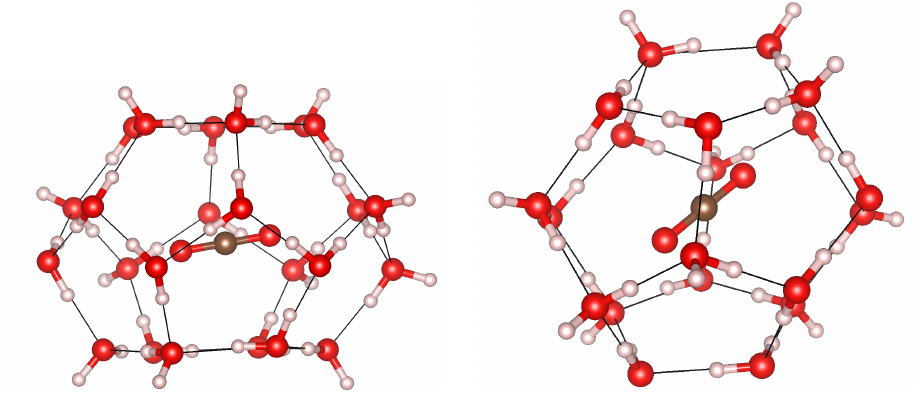
Figure 5. Optimized configurations of the CO 2 molecule inside the H ( left ) and P ( right )